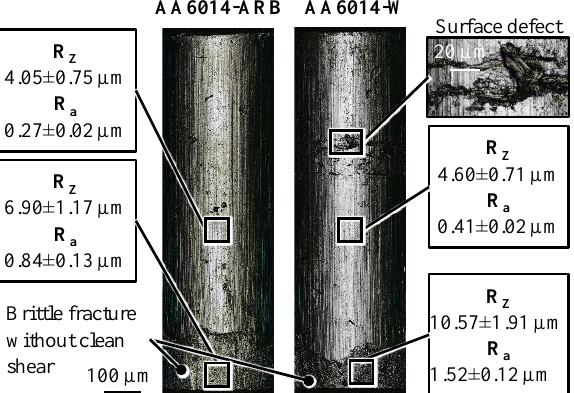
Figure 8. Comparison of the surface and component quality of the micro parts made of AA6014-W and AA6014-ARB.